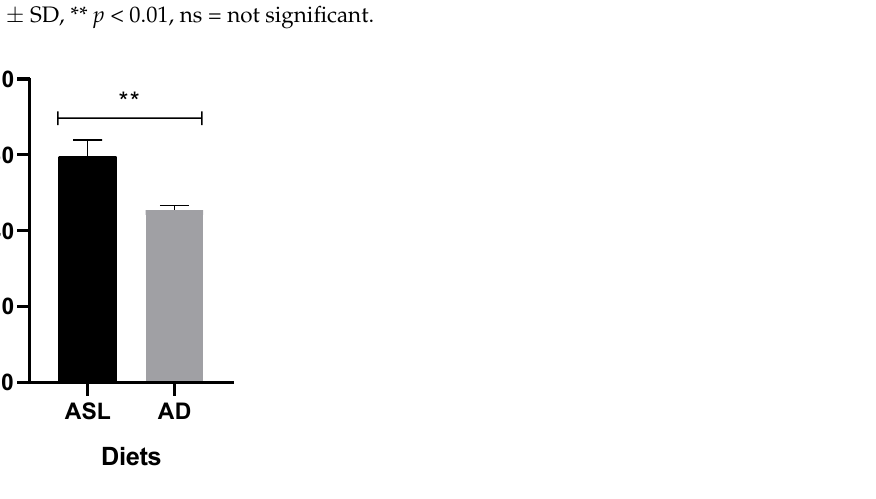
Figure 5. Developmental time (d) of Acanthotomicus suncei reared on American sweetgum logs and the artificial diet. ASL: American sweetgum logs; AD: artificial diet. Mean ± SD, ** p < 0.01.